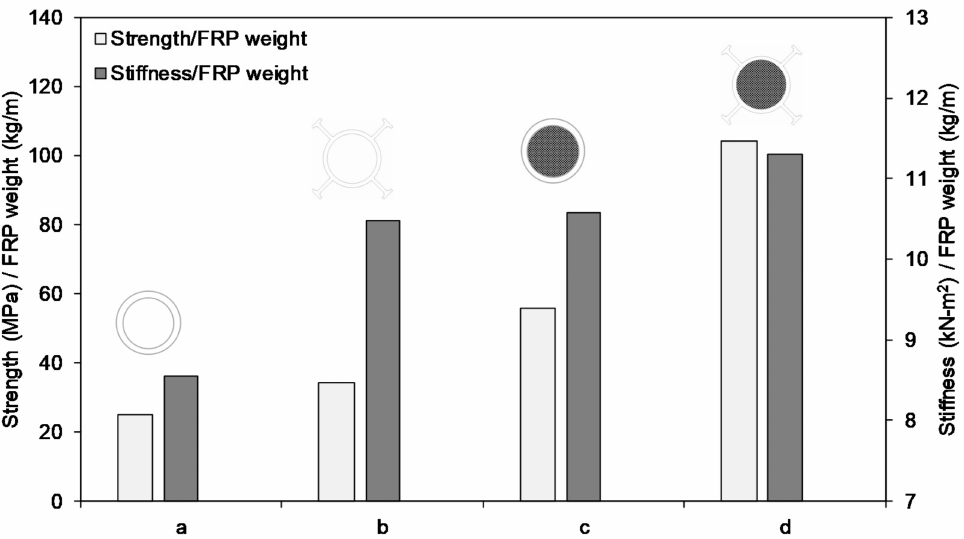
Figure 9. Comparison between round FRP tubes with and without external flanges ( a ) hollow round tube [9], ( b ) hollow externally flanged round tube, ( c ) concrete-filled round tube [9] and ( d ) concrete-filled externally flanged round